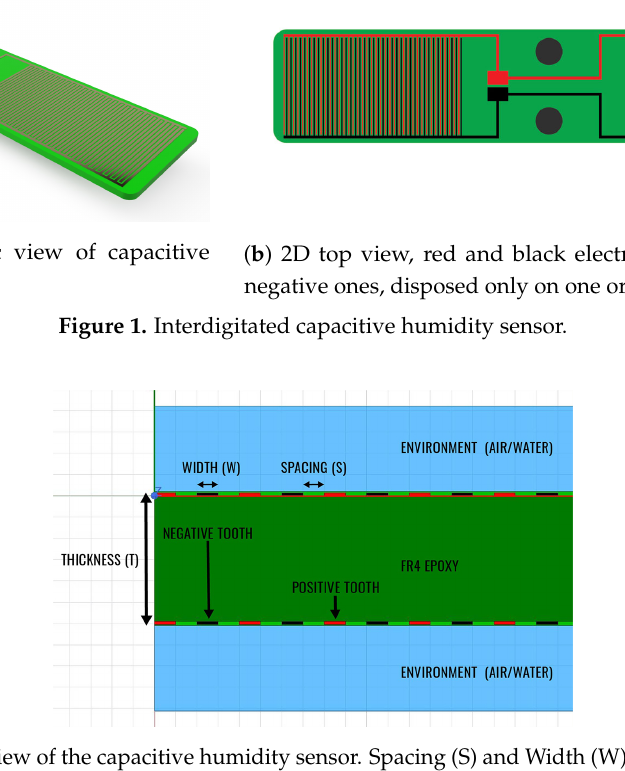
Figure 2. Section view of the capacitive humidity sensor. Spacing (S) and Width (W) are the parameters with the highest influence in the sensitivity of the sensor with Thickness (T) with a very small impact. The stackup is composed of soldermask, copper, FR4 epoxy, copper and soldermask.